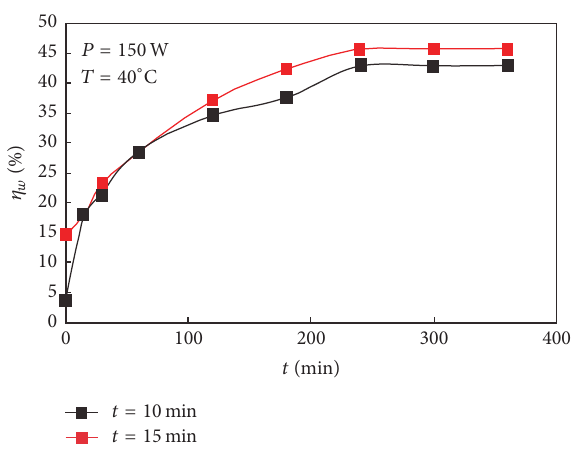
Figure 11: The impact of different ultrasonic treatment time (10min and 15min) on sonochemistry dehydration.